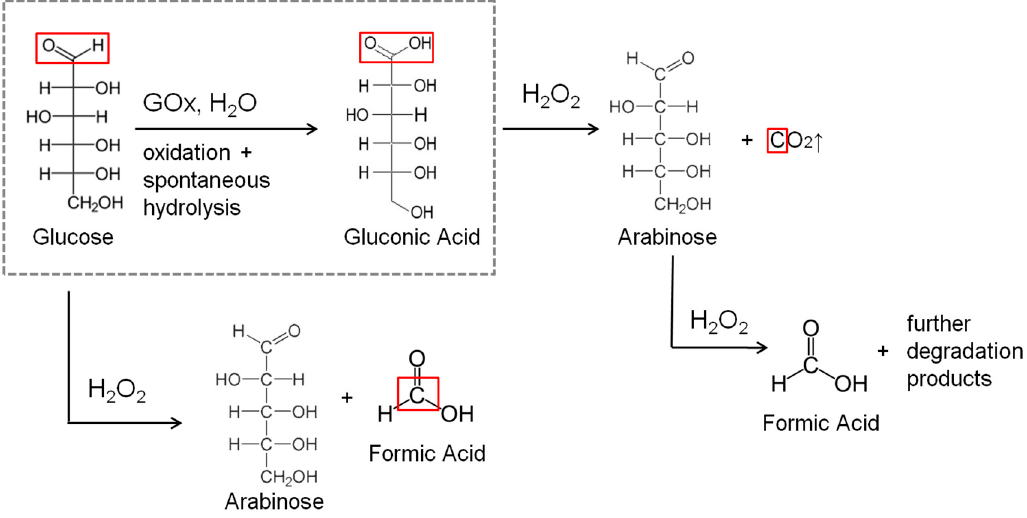
Figure 5. Proposed pathway of glucose oxidation to gluconic acid and other by-products.